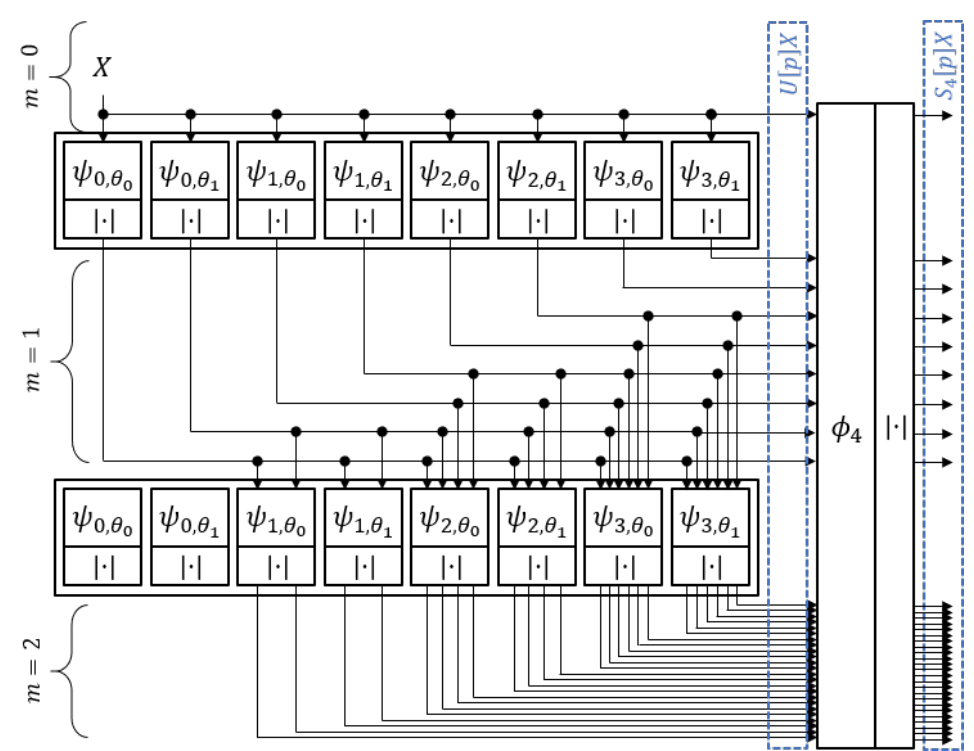
Figure 2. WSN paths with J = 4, L = 2, and M = 2.